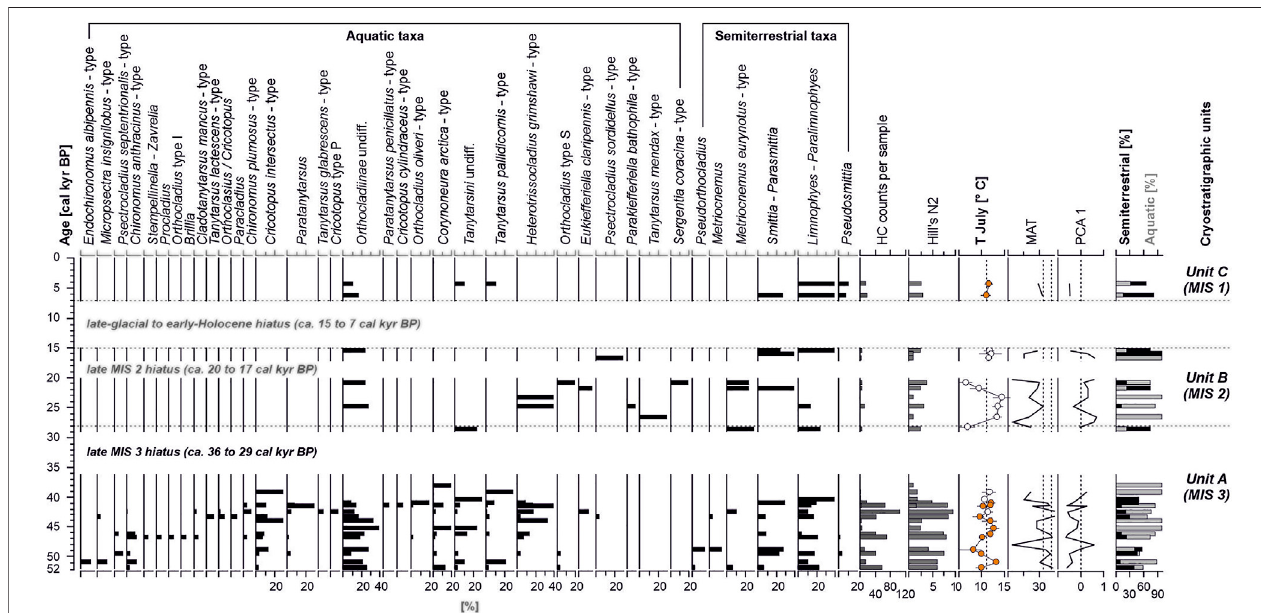
FIGURE 5 | Chironomid diagram of the Sobo-Sise Yedoma record. HC - head capsule, MAT - Modern Analogue Technique, PCA 1 - fi rst axis of the principal component analysis. The dotted line in the reconstruction T July reconstruction indicates the modern value of 11 ° C. The dotted lines in the MAT indicate the 75% (30.40) and 95%(34.97)con fi denceintervals.NotethathollowsymbolsofthereconstructedT July arebasedonlowHCconcentrationsand shouldthereforebeconsidered with